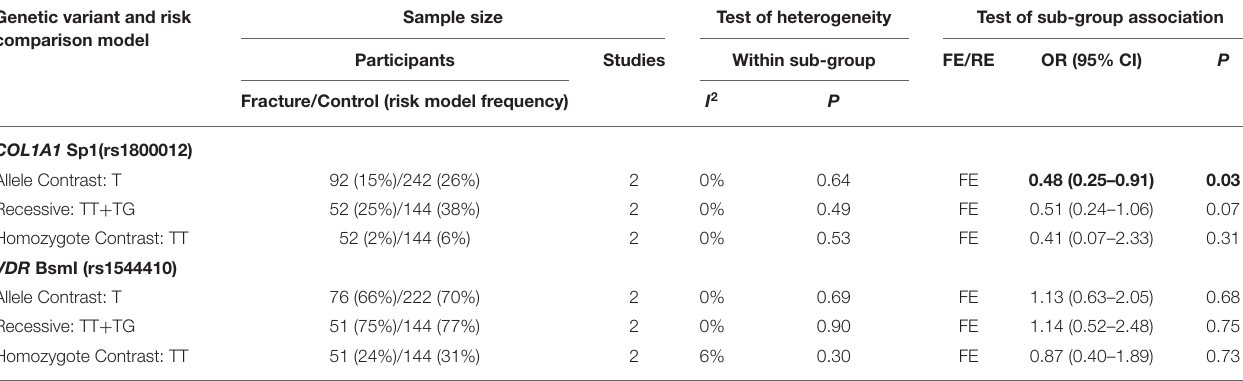
TABLE 6 | Summary effects of case-control association studies for genetic variants associated with fracture occurrence risk in physically active females only. Genetic variant and risk comparison